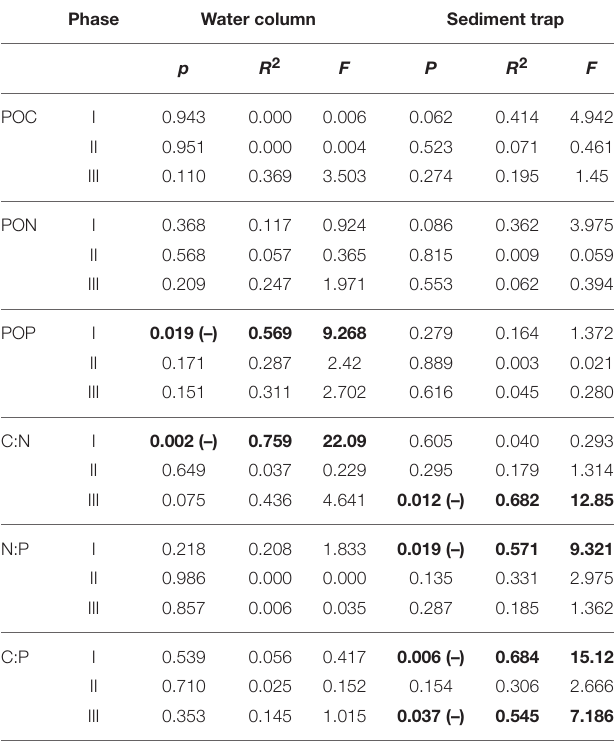
TABLE 2 | Statistical results from the linear regression analysis on response means over the respective phases. Phase Water column